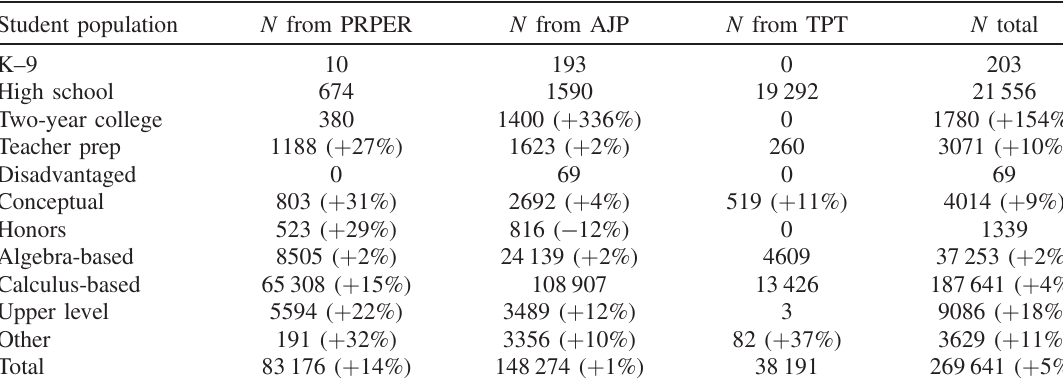
TABLE II. Data corrections based on review of one-third of the papers. Changes to values given in Table I are shown in parentheses: Entries without percentages given remained the same after review, or were changed by less than